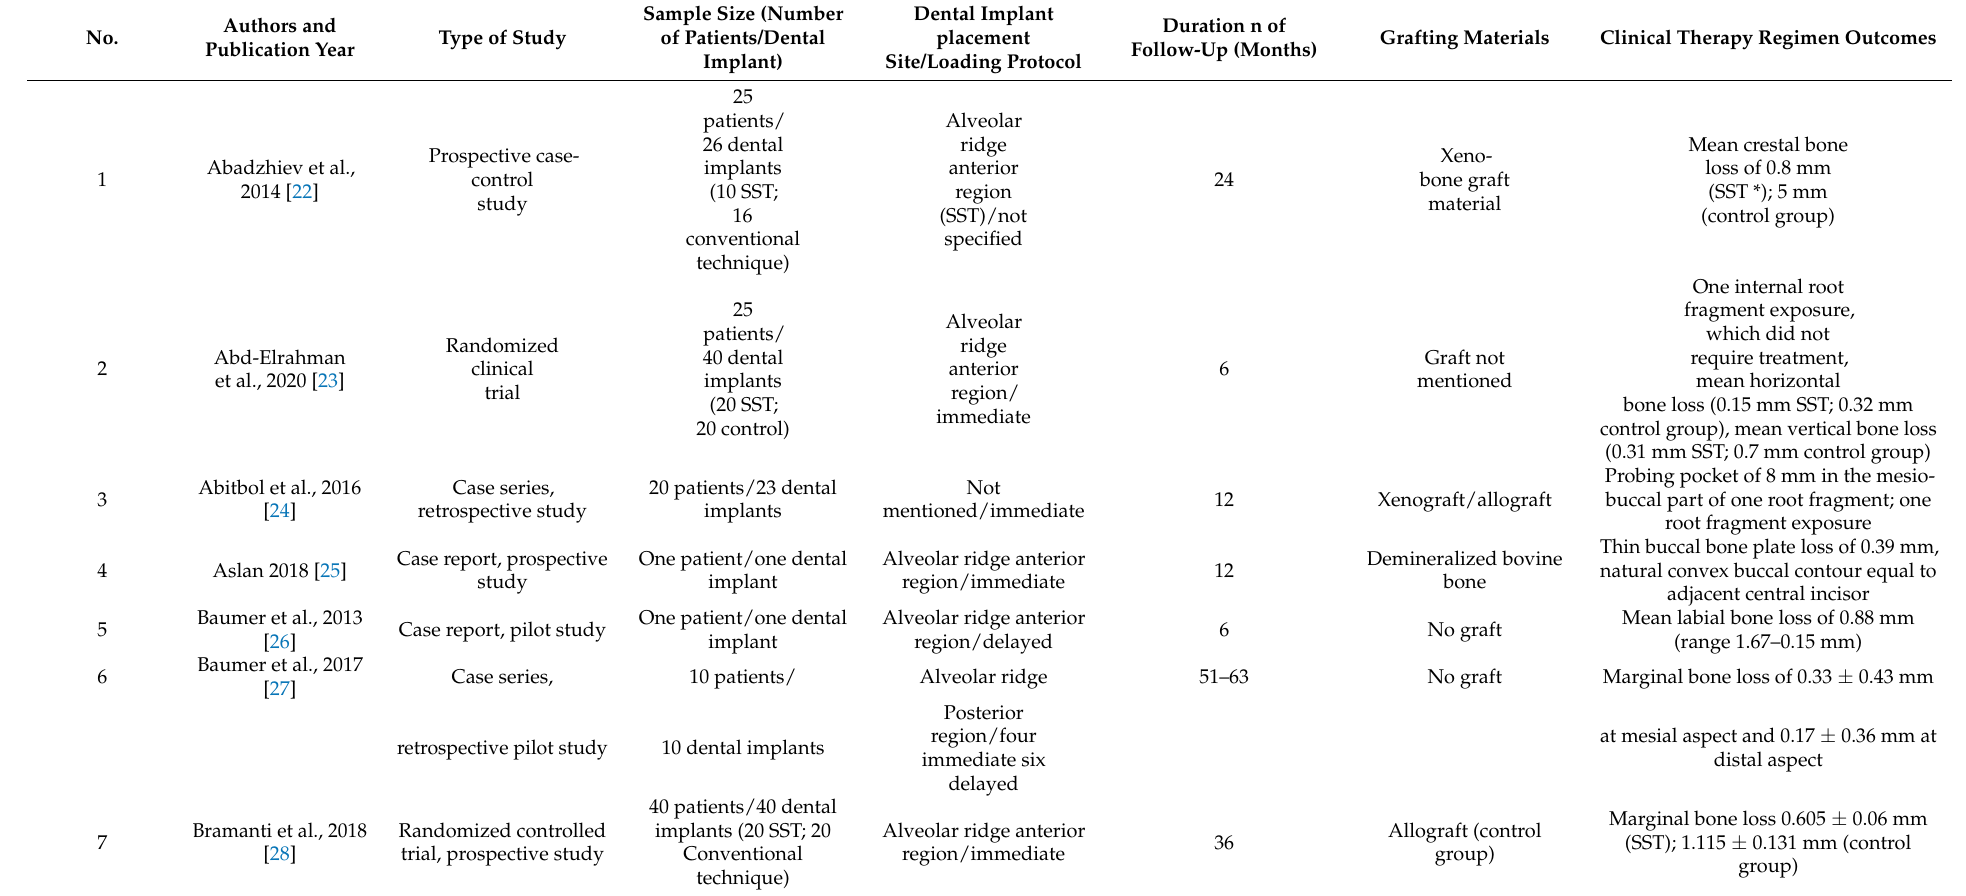
Table 1. Clinical studies on immediate dental implant placement in conjunction with the socket-shield technique and its clinical therapy regimen outcomes. Abstracts are not included in the